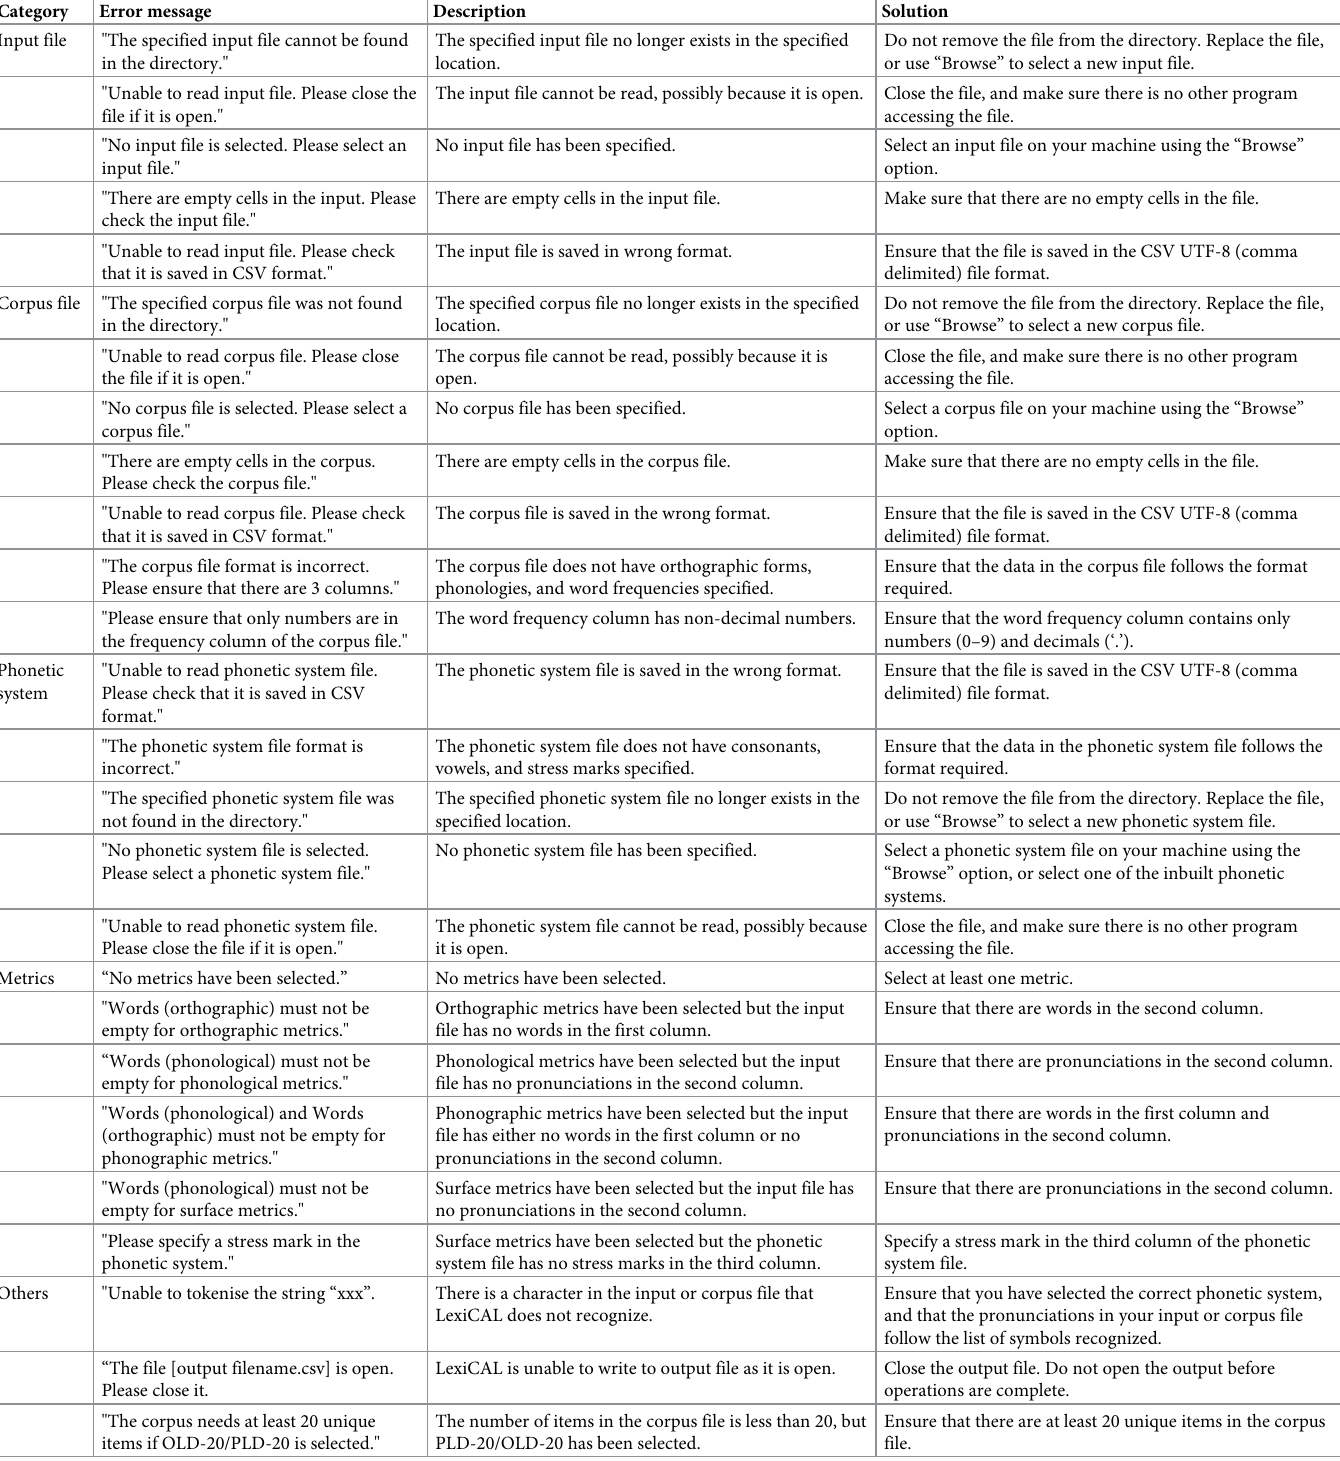
Table 4. List of error messages in LexiCAL and their solutions.